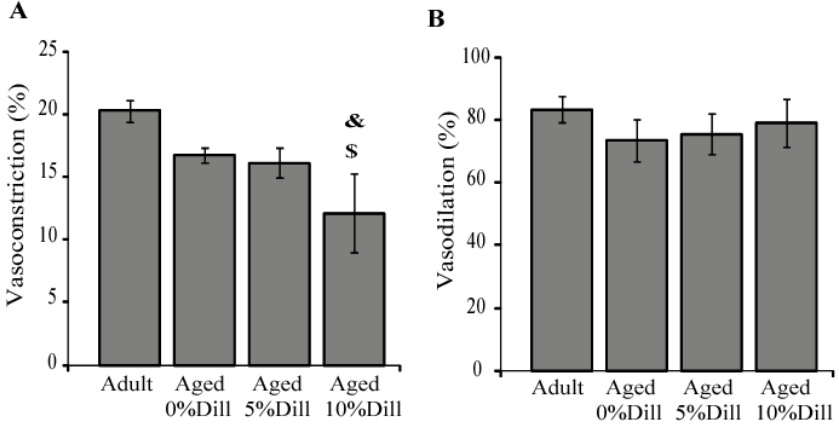
Figure 6 . Influence of 5% and 10% DE treatment on the ascending aorta reactivity in aged mice, compared to adult or aged untreated animals. ( A ) Response to the vasoconstrictor phenylephrine (10 −5 M) on the arterial inner diameter; ( B ) response to the vasodilator acetylcholine (10 −5 M) on the restoration of the inner diameter of the aorta pre-constricted with 10 −5 M phenylephrine. Dill: DE. & Significant difference between 10% DE-treated aged mice and untreated adult (control) mice (one-way ANOVA followed by LSD tests, p ≤ 0.05). $ Significant difference between 10% DE-treated aged mice and untreated aged (control) mice (one-way ANOVA followed by LSD test, p ≤ 0.05). n = 4–7 per group.